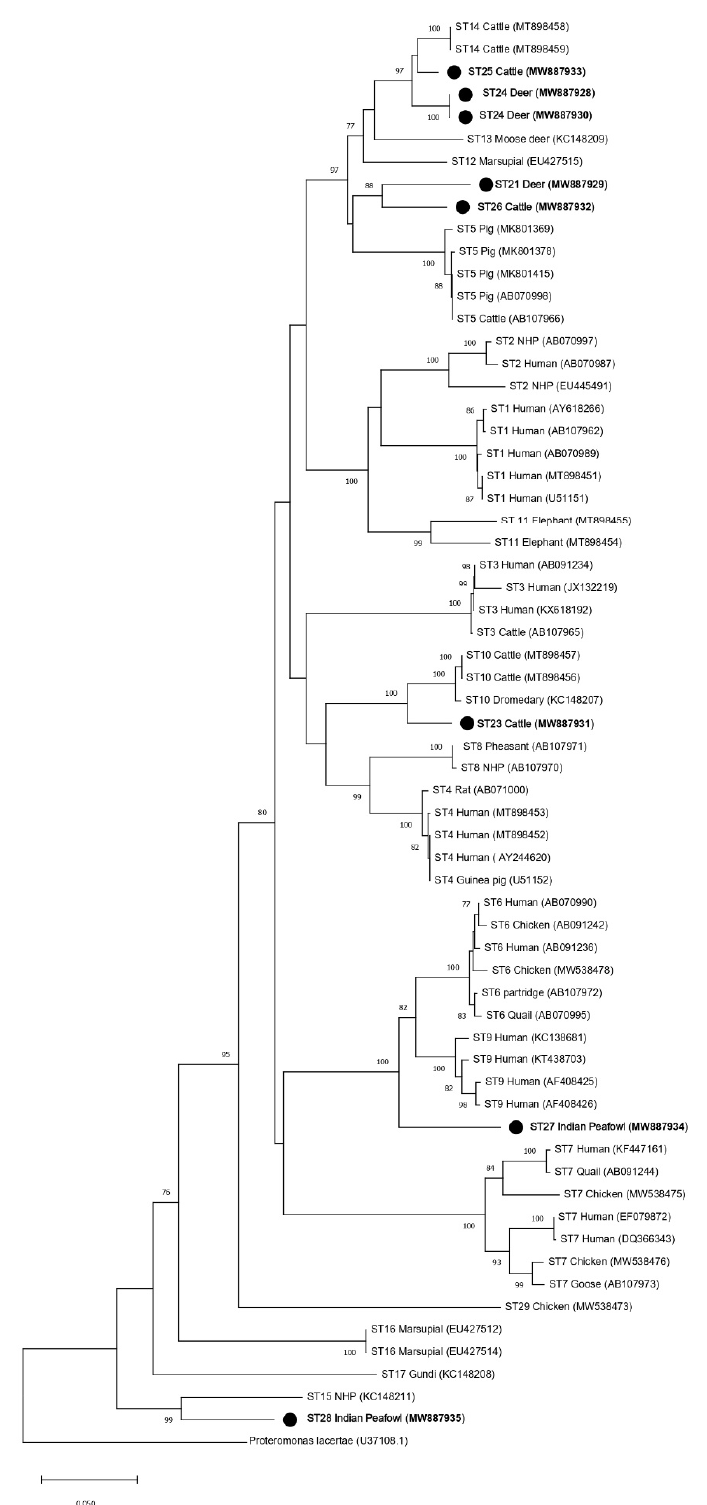
Figure 7. Phylogenetic relationships among Blastocystis partial SSU rRNA gene sequences of the Santin region sequences generated in the present study (represented with a black filled circle) and representative reference sequences of the accepted subtypes (Table 2). Proteromonas lacertae was used as outgroup taxon to root the tree. Analysis was conducted by a neighbor-joining method. Genetic distances were calculated using the Kimura two-parameter model. This analysis involved 64 nucleotide sequences, and there were a total of 568 positions in the final dataset. Bootstrap values lower than 75% are not